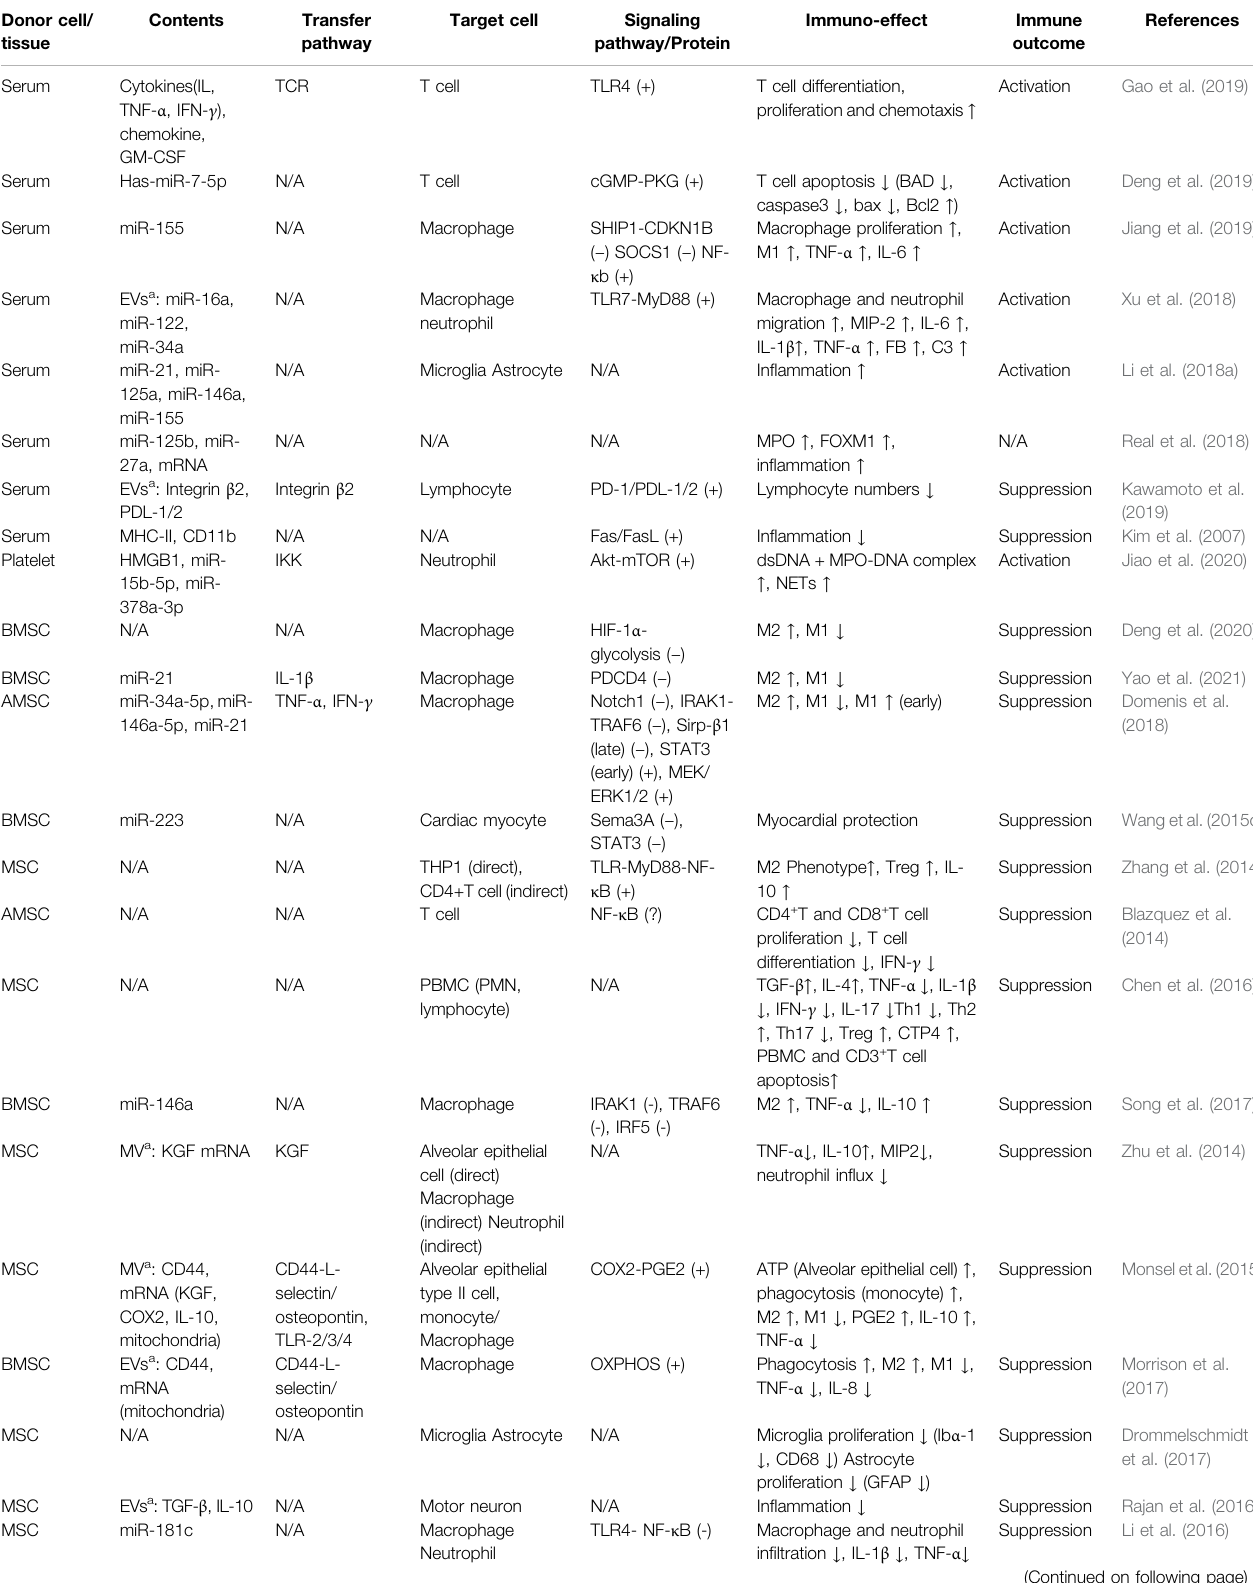
TABLE 1 | Immunomodulatory effect of exosomes derived from non-immune cells in sepsis. Donor cell/